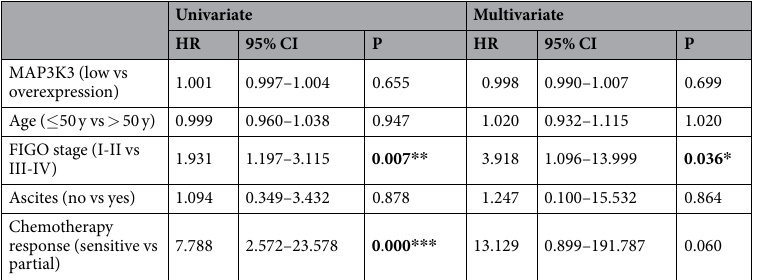
Age ( ≤ 50 y vs > 50 y) 0.999